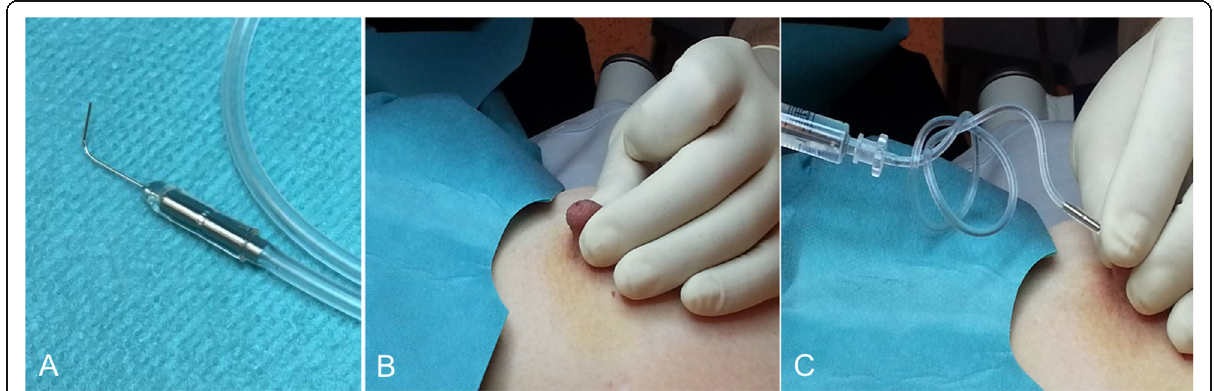
Fig. 14 Galactography technique. 30-gauge cannula ( a ); the nipple must be firmly stabilized between the thumb and forefinger ( b ); canalization of the discharging orifice and contrast injection ( c ). A magnified craniocaudal view is obtained with the cannula taped in place and the breast